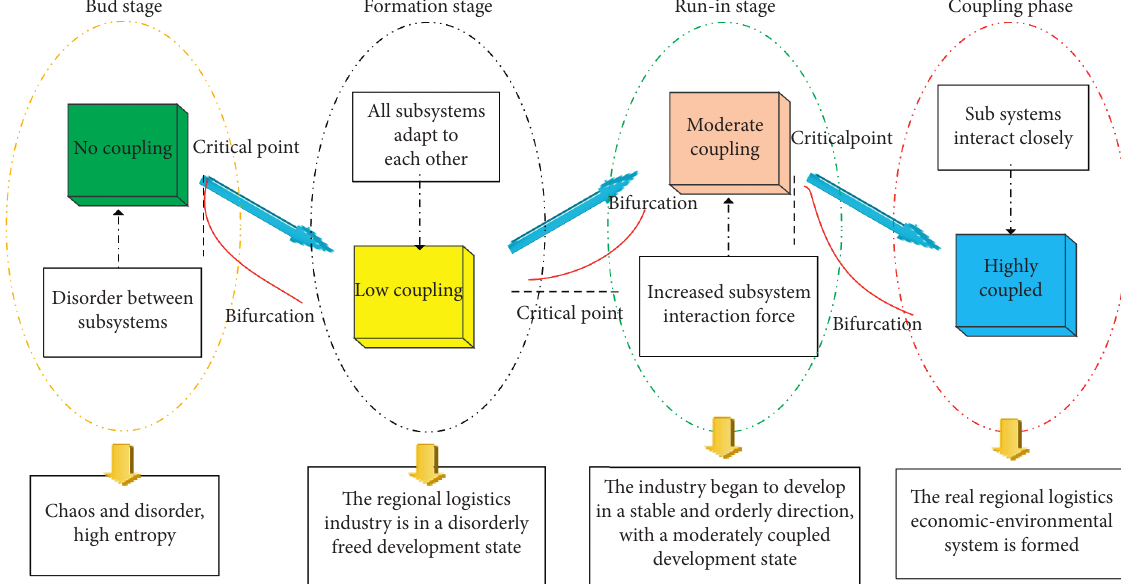
Figure 3: Development stage of regional logistics-economic-environmental system